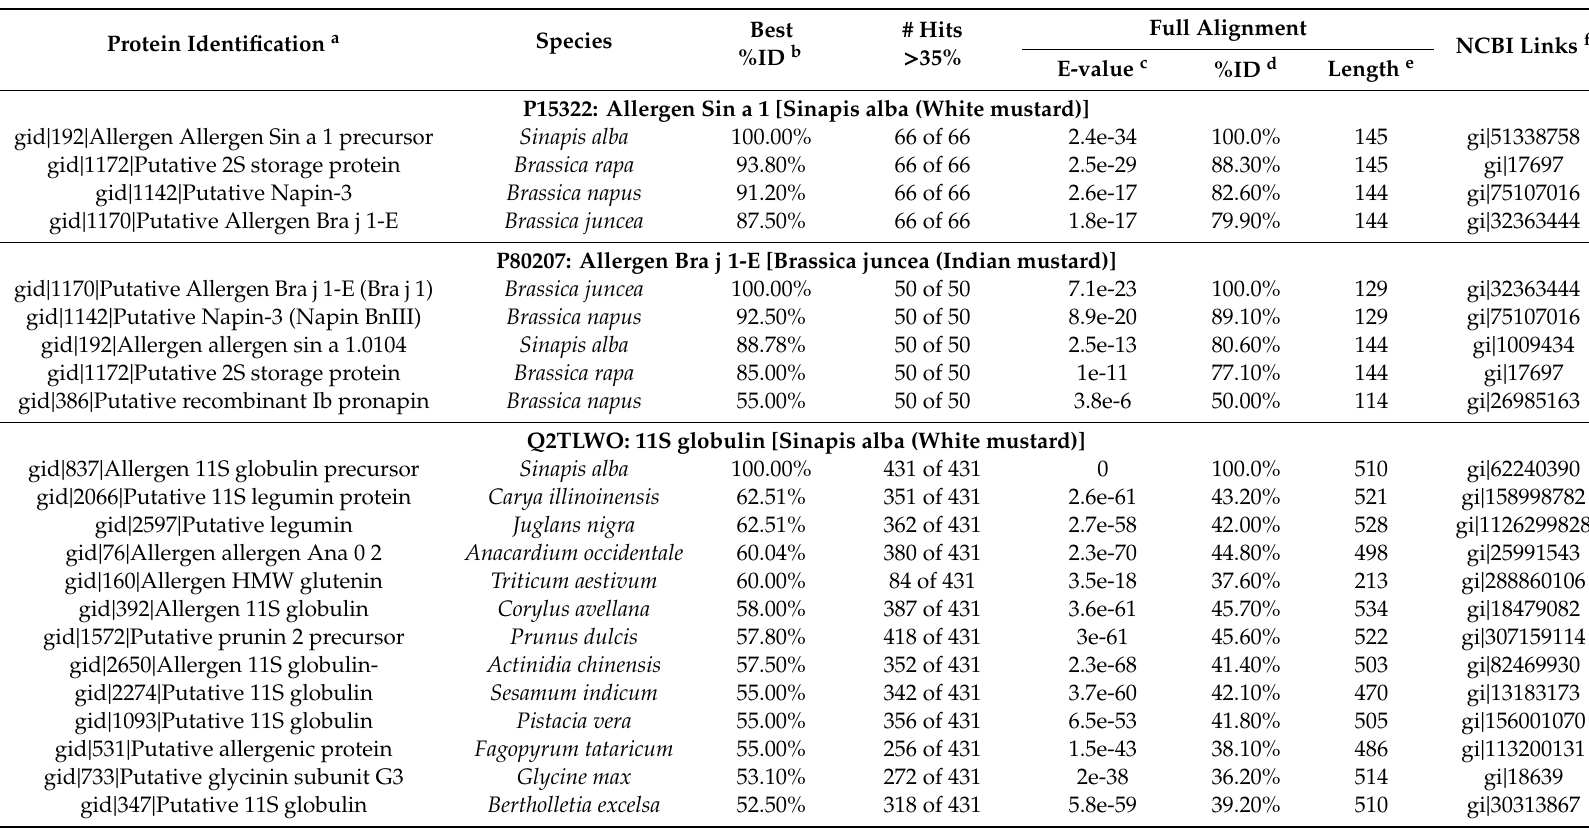
Table 3. Significant sequence alignment of the identified mustard IgE-binding proteins with allergens from the Allergen Online database. Protein Identification